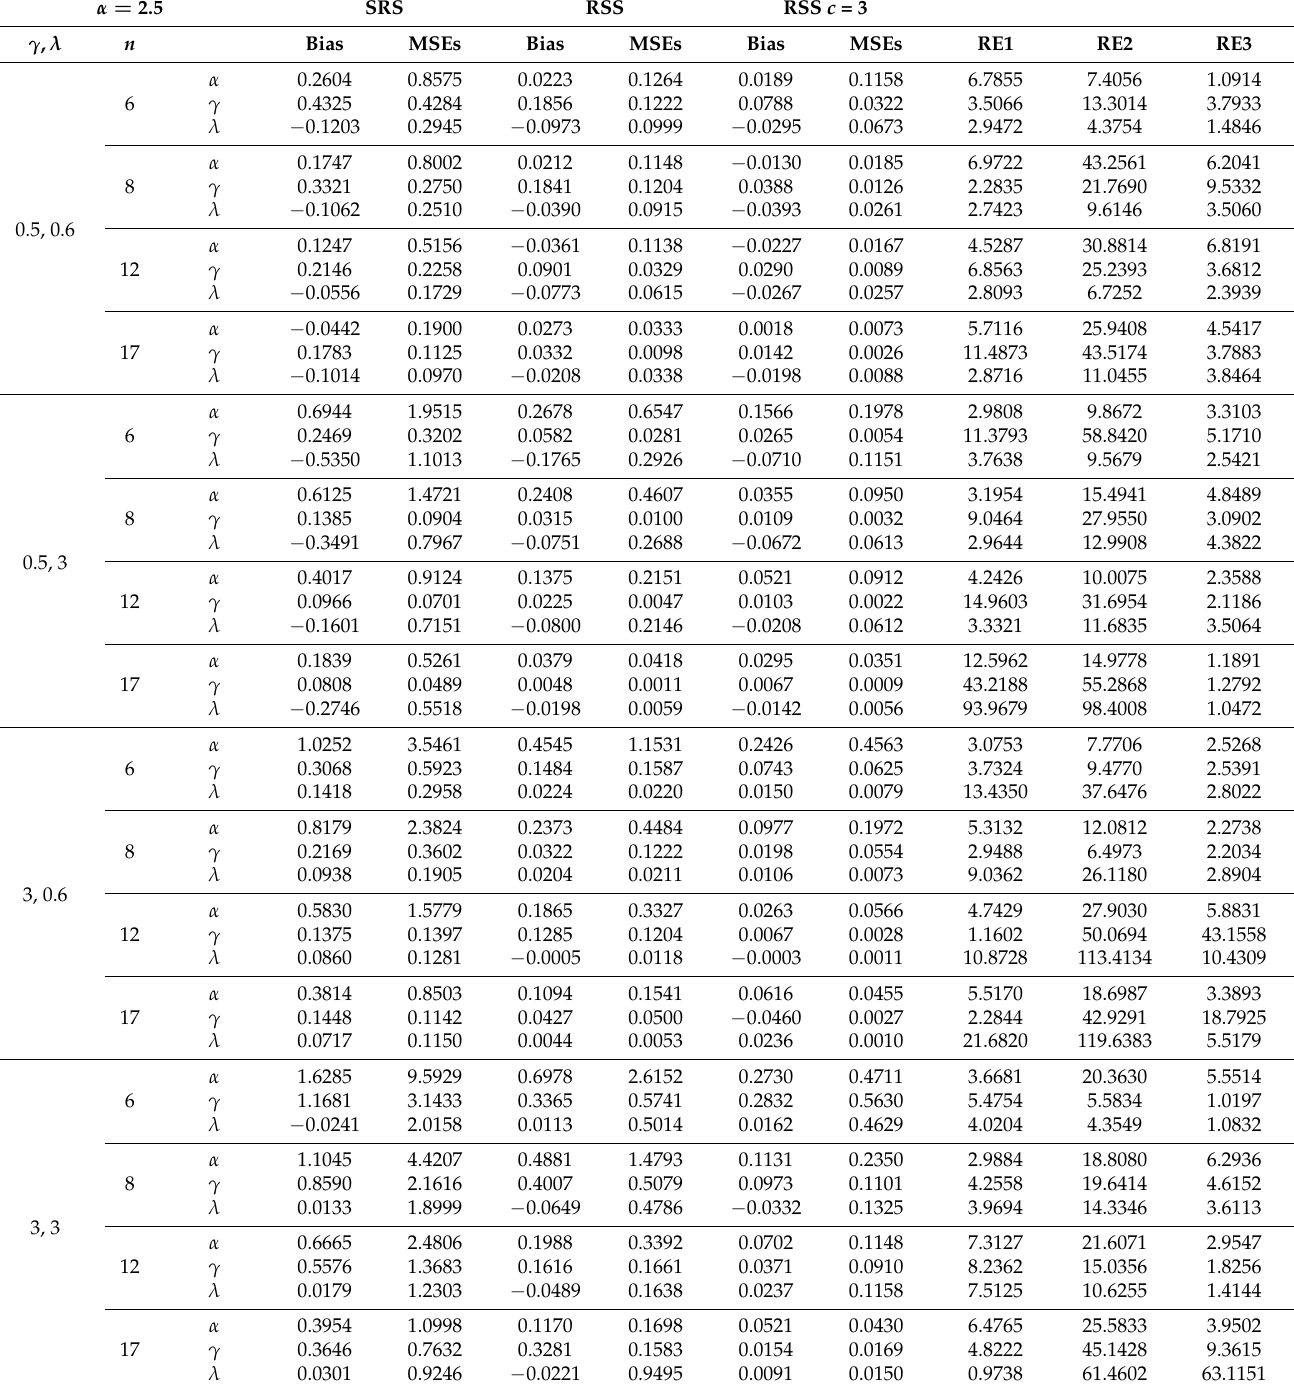
Table 6. MLE under the SRS and RSS of parameters α =